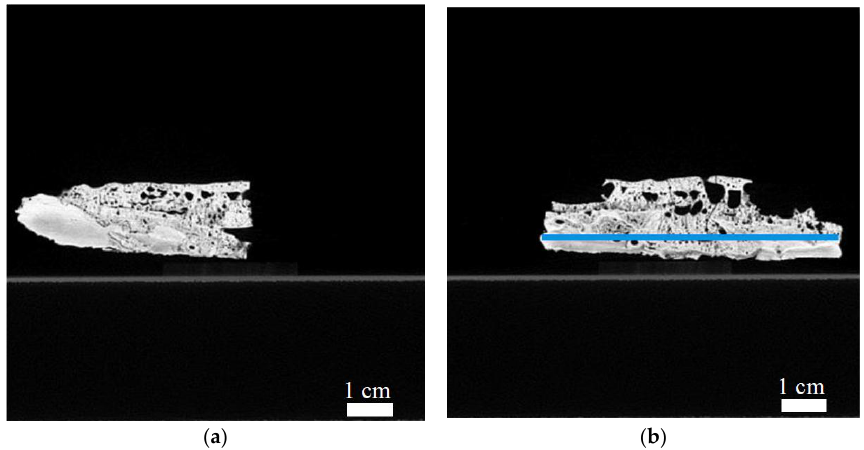
Figure 6. X-ray images of sample B: ( a ) Location represented by the yellow line in Figure 5; ( b ) location represented by the red line in Figure 5.